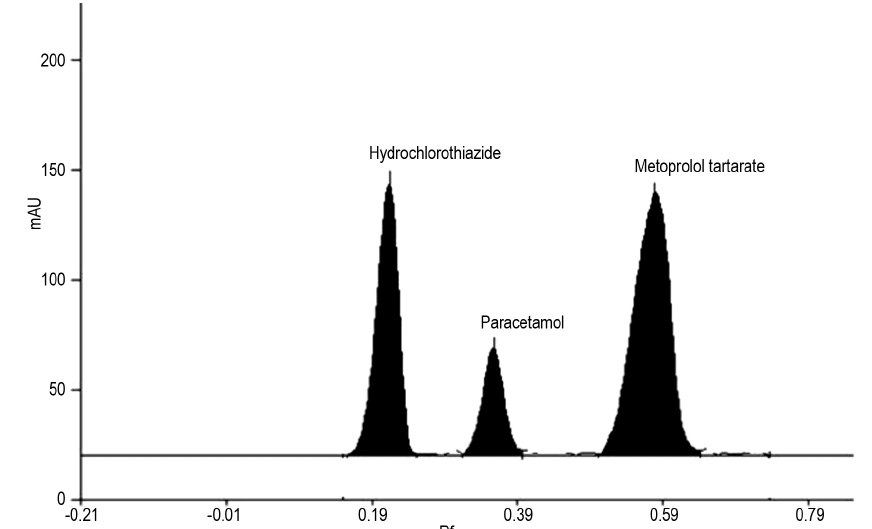
FIGURE 2 - Densitogram of hydrochlorothiazide (Rf(0.13±0.04), paracetamol Rf(0.28±0.05) and metoprolol tartarate